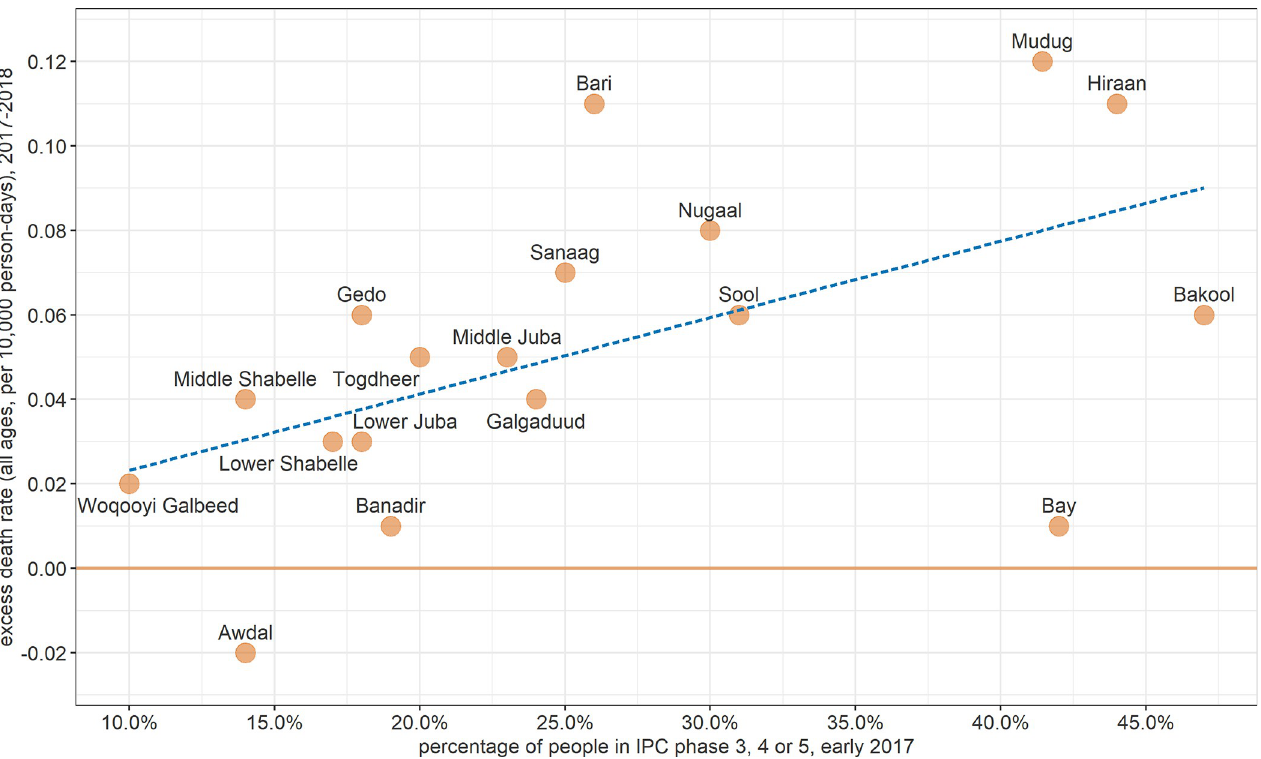
Fig 6. Correlation between Integrated Phase Classification (IPC) projections (early 2017) and estimated excess death rate among all ages (2017–2018), by